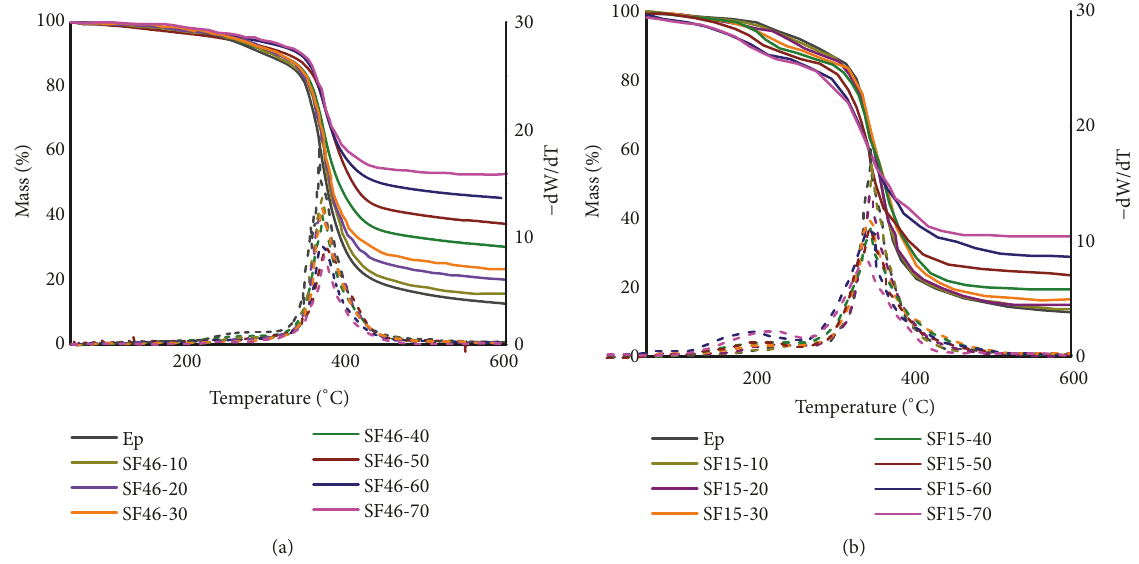
Figure 9: TG-DTG traces of epoxy syntactic foams: (a) SF46 and (b) SF15 (dotted lines represent